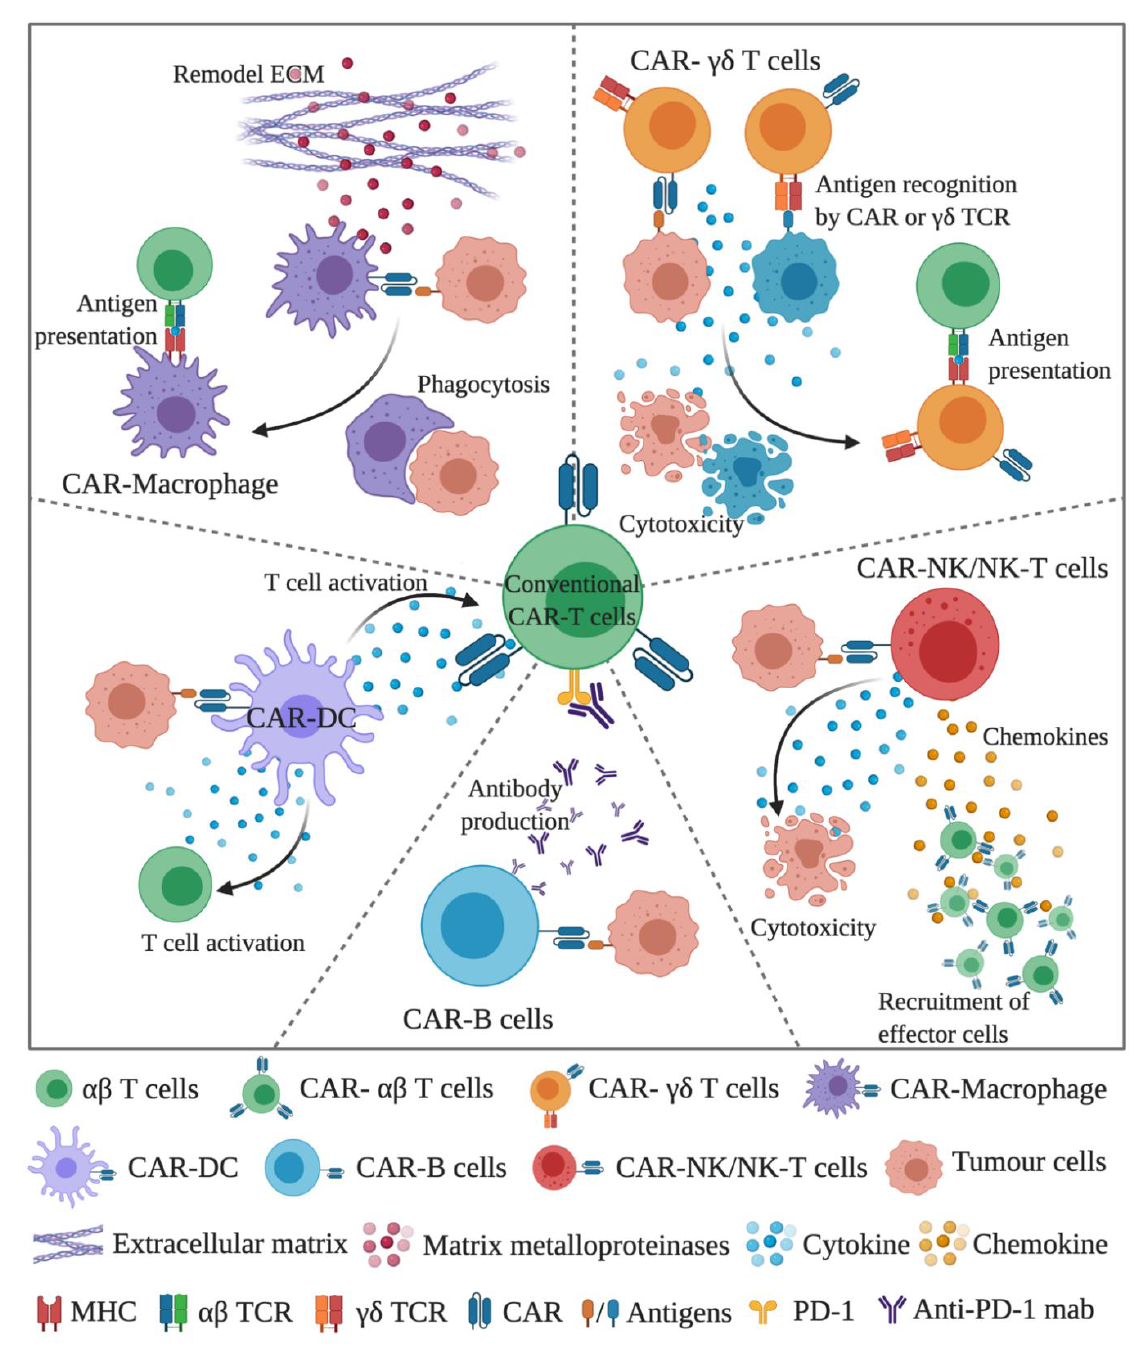
Figure 1. A schematic diagram demonstrating the concept of using conventional CAR-T cells in the combination of CAR-immune cells. In the combination, CAR- γδ T cells and CAR-macrophages can directly kill tumour cells and facilitate antigen presentation to cope with the tumour heterogeneity issue. CAR-macrophages can also remodel the extracellular matrix through the production of MMP. CAR-NK/NK-T cells can induce the early onset of anti-tumour activity, followed by the recruitment of CAR-T cells through chemokines. CAR-DC can support the full activation signals to CAR-T and the bystander T cells. CAR-B cells can be used as an ideal platform to deliver therapeutic antibodies, such as anti-PD1 antibody. (The figure is created with